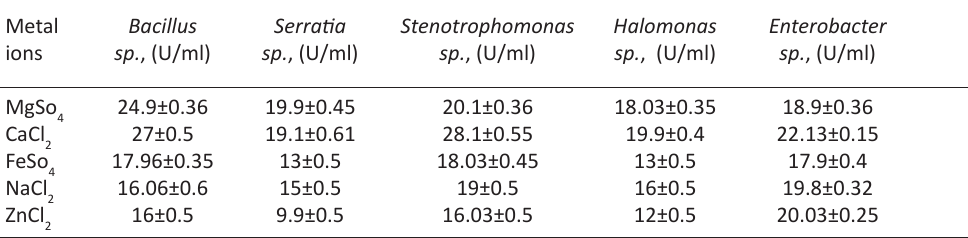
Table 4. Effect of Metal ions on lipase production